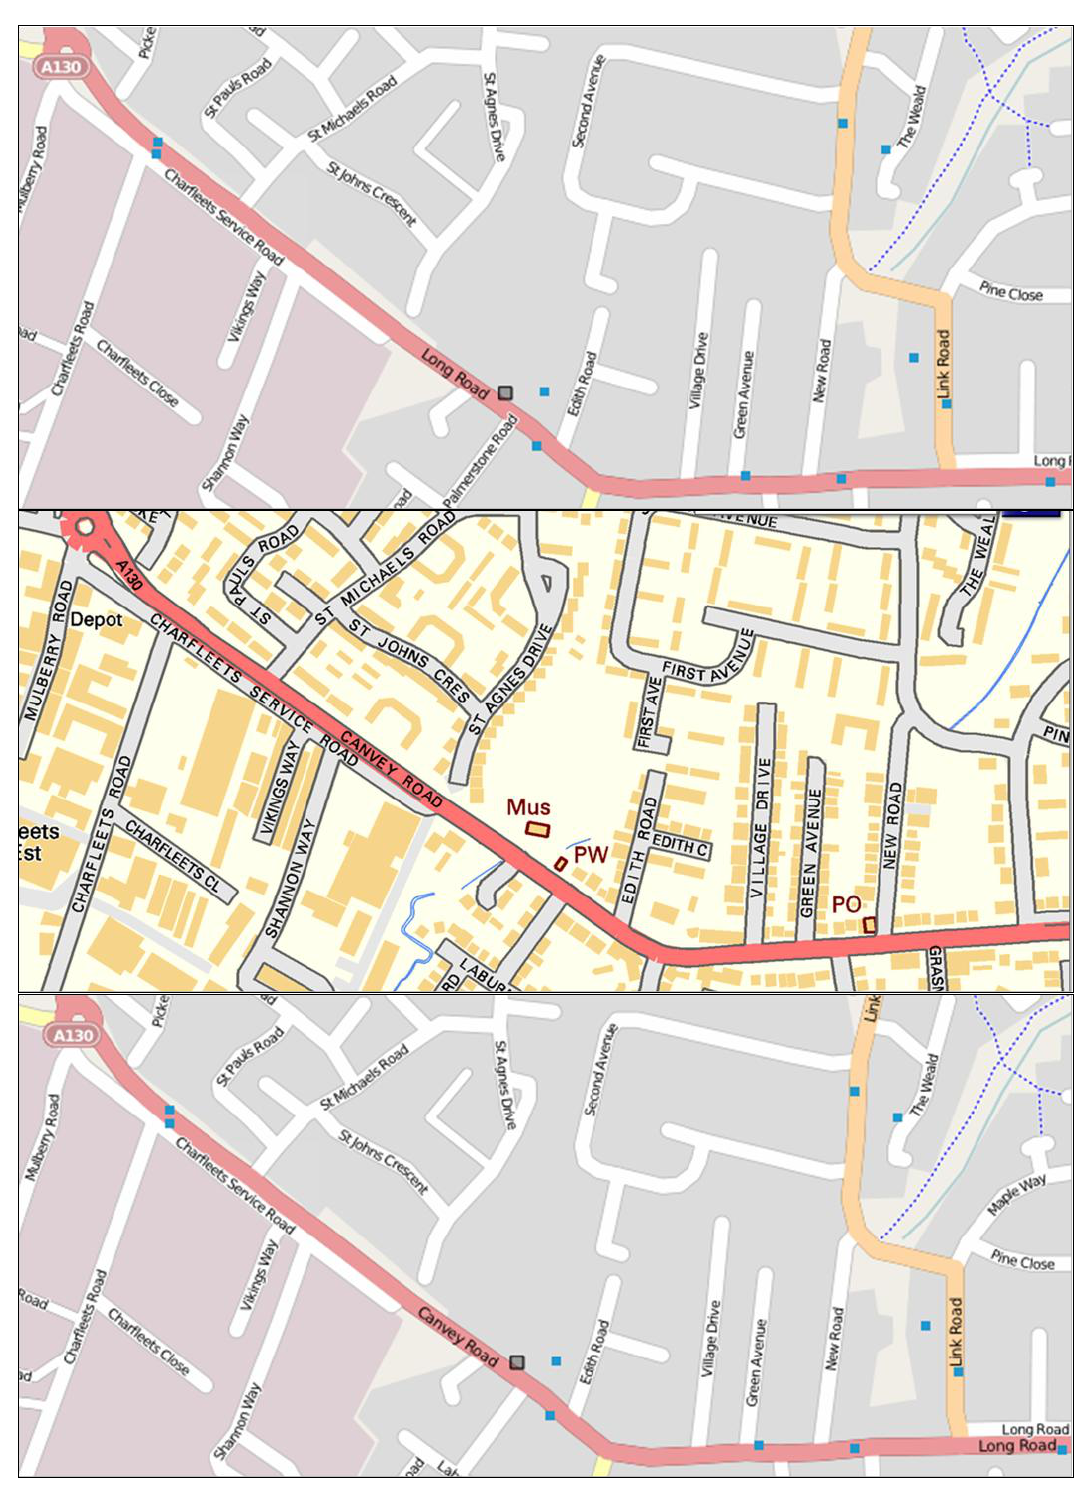
Figure 4. A sample of matched road names (Long road should be Canvey Road, near London). ( Top ): original OSM; ( Middle ): OS Open Data map of the same area; ( Below ): updated in